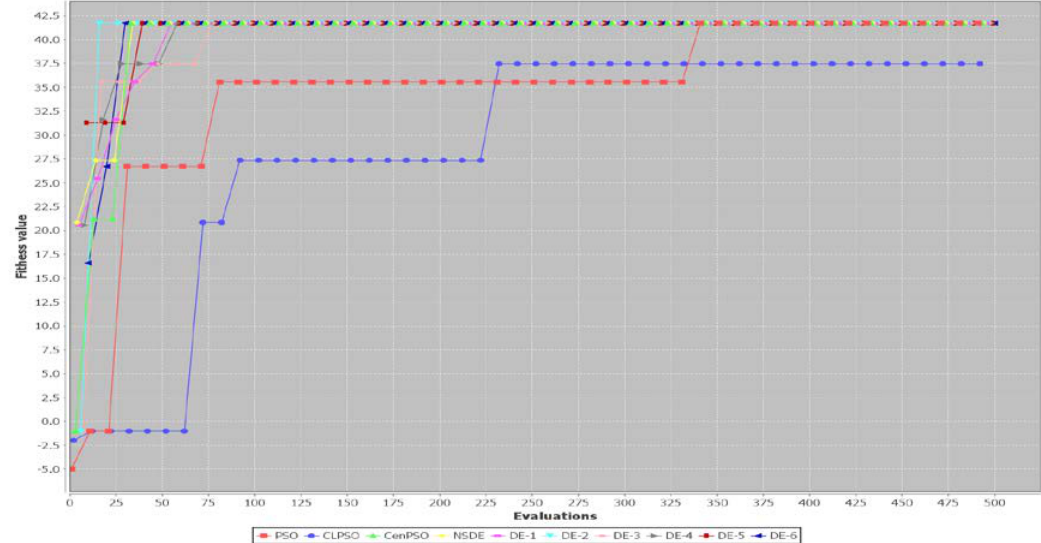
Figure A3. Convergence speed of a run of each algorithm for Case 3 with POP = 30.